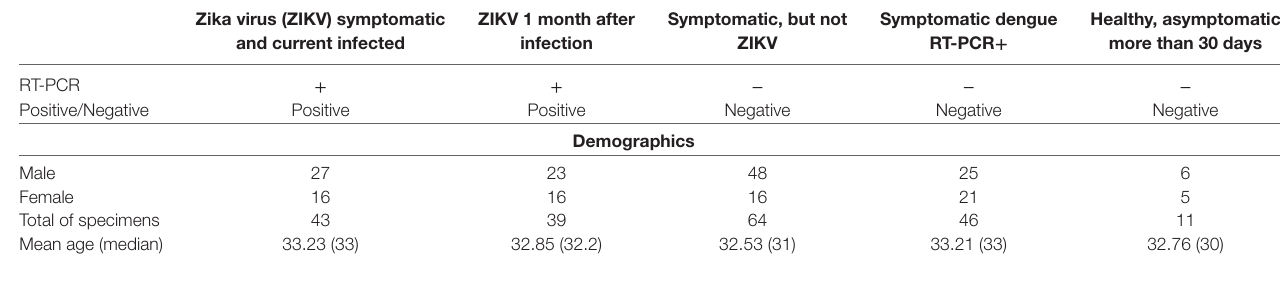
TaBle 1 | Summary of the specimens included in the study regarding demographic information, clinical conditions, and results from reverse-transcriptase polymerase chain reaction (RT-PCR) performed during the high viremia